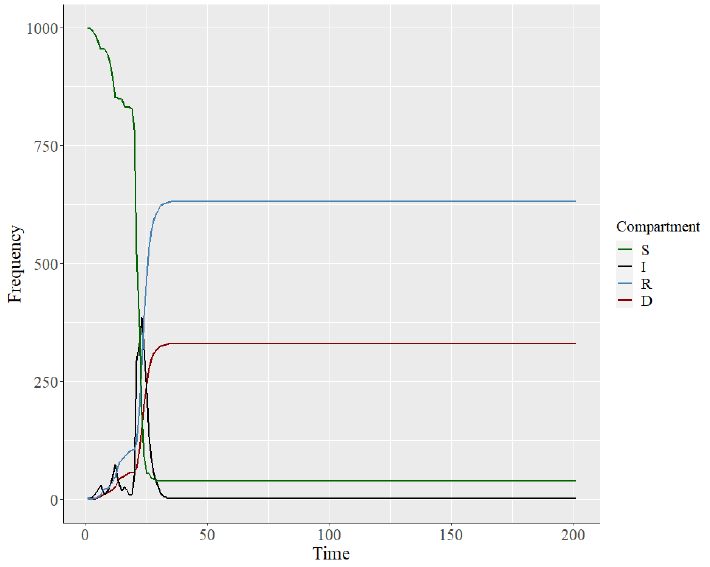
Figure 5. Simulated epidemic curve on a random graph.